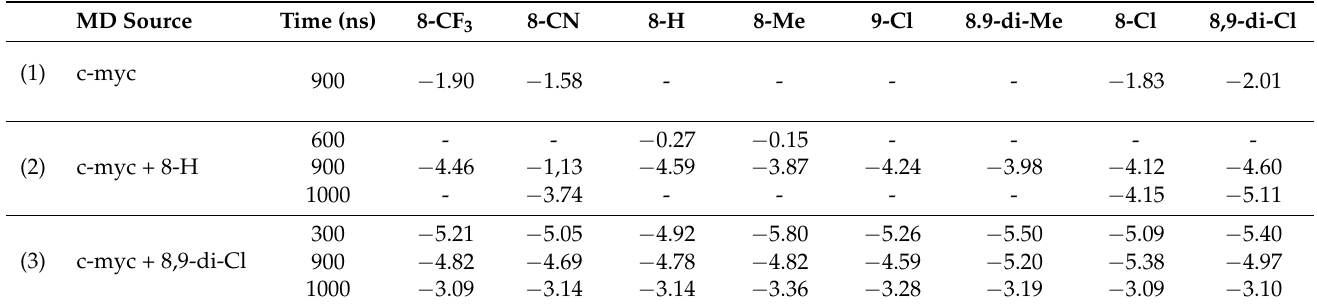
c-myc + 8,9-di-Cl